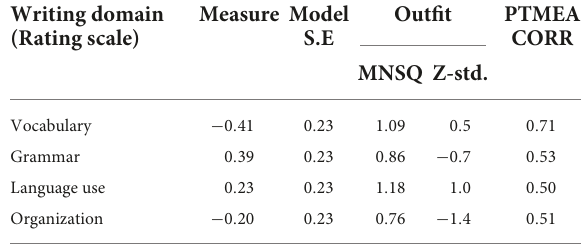
TABLE 2 Summary statistics of essays, rating scale, and raters’ reliability.